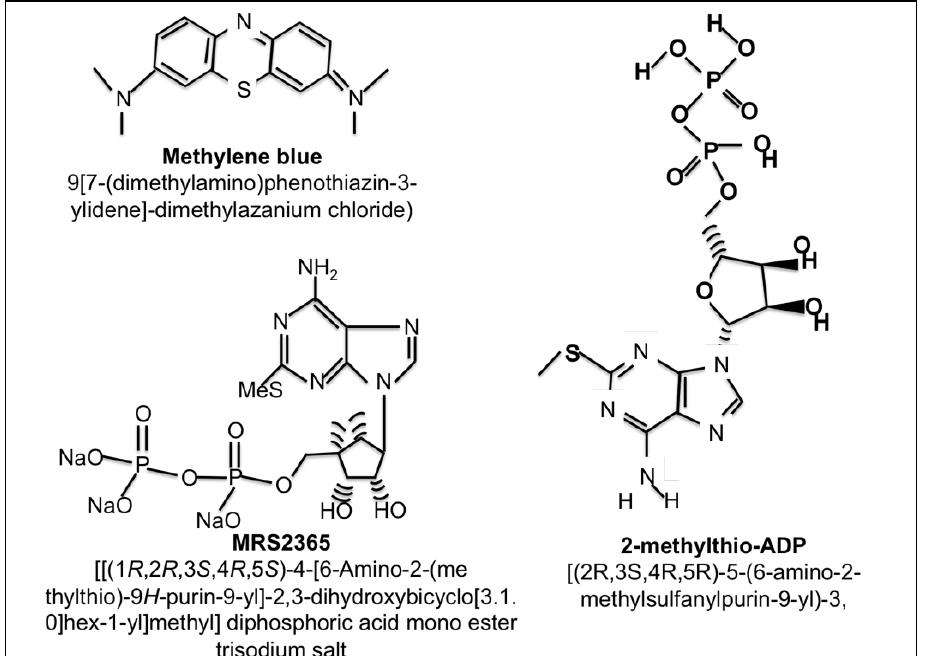
Figure 3. Chemical structures of Methylene Blue, 2-methylthio-ADP and